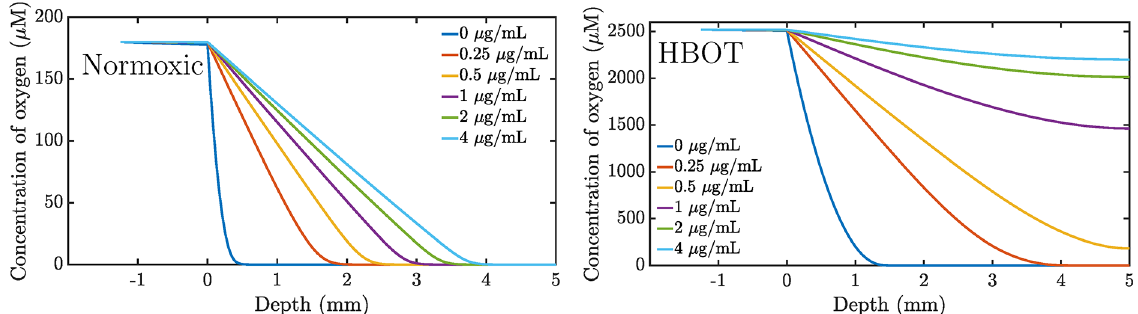
Fig 6. Oxygen penetration. Simulation of oxygen penetration in a 5 mm biofilm following a 4 hour treatment scheme with six different ciprofloxacin dosings. The initial concentration ciprofloxacin in the supernatant is indicated in the figure. The equilibrated concentration is 5 times lower. Left: Normoxic treatment. Right: Hyperbaric oxygen treatment.